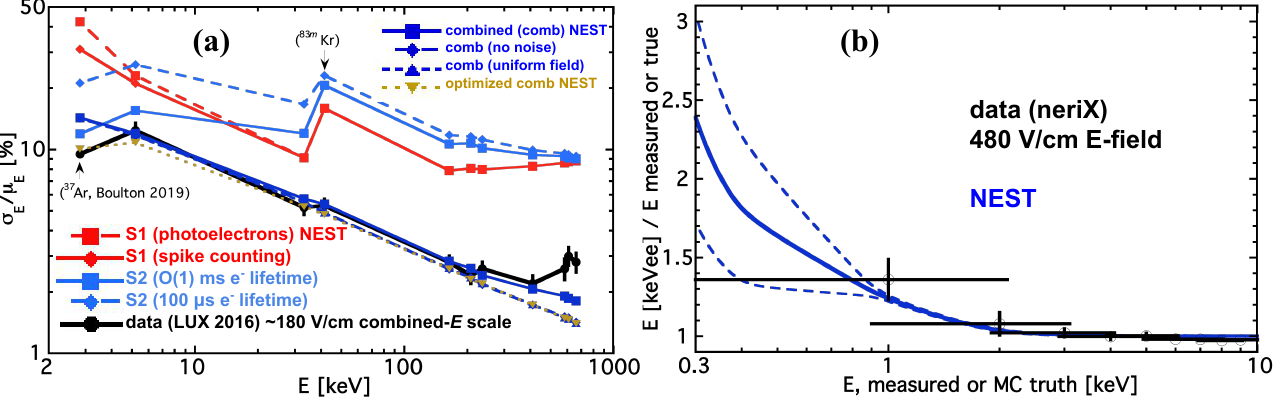
Figure 2. Review of E resolutions and means. ( a ) Resolution vs. E for LUX monoenergetic calibration plus background [52]. Only combined resolutions published (black), but S1 (red) and S2 (cyan) scales included from NEST, to show they are mutually comparable at O (10–1000) keV. The lowest- E point is optimized as done in PIXeY, so anomalously good (low). NEST combined scale blue (below S2 only in cyan except for 37 Ar) and optimized gold. w 1 in optimal scale varies from 0.26 to 1.0 from 2.8 to 662 keV, while w 2 falls from 1.45 to 1.00. (Lines are guides not fits.) ( b ) Data from neriX (Columbia’s small-scale calibration chamber, like PIXeY) as black points vs. measured recoil energies from Compton scatters [65] compared to NEST in blue vs. true energy known from MC, showing consistent deviation for both in reconstructed energies for a combined but non-optimized scale due to threshold bias (weights as used for NEST in gold in ( a ) correcting for this not applied purposely in blue in ( b ) to show this